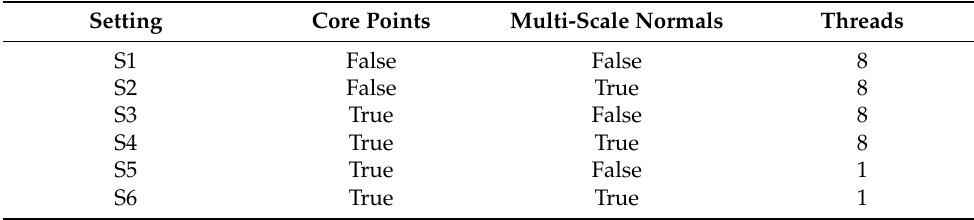
Table 4. Tested M3C2 setting for core point and multi-scale normals. Setting Core Points Multi-Scale Normals